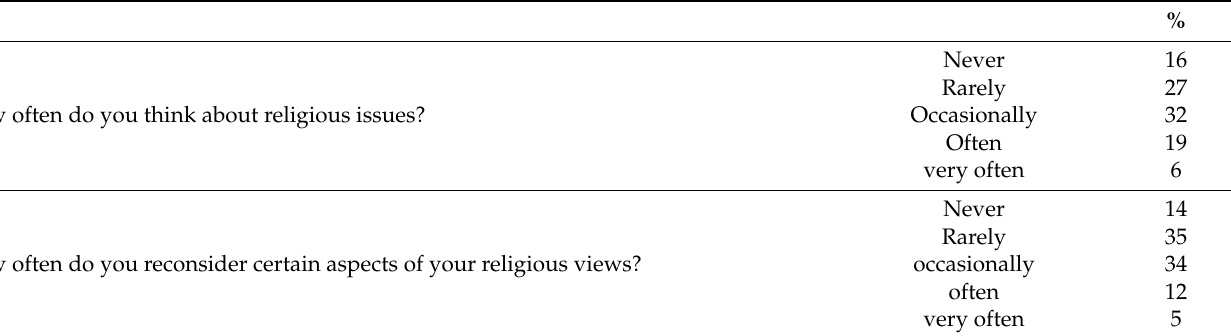
Table 3. Religiosity measures and religious practice